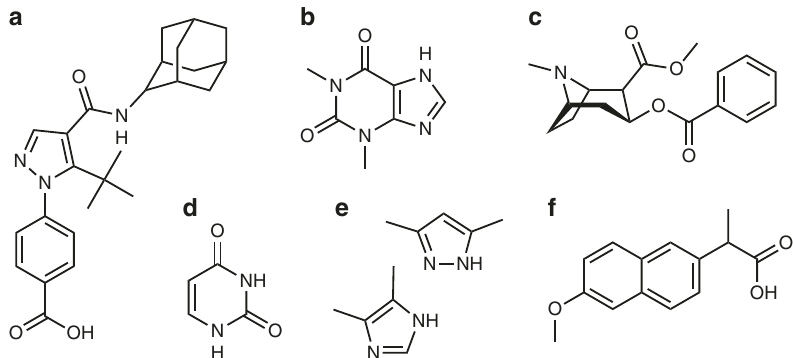
Fig. 6 Chemical structures of the six molecules used to evaluate the correlation between experimentally measured 1 H chemical shifts and the shifts calculated by ShiftML. The structures are given as AZD8329 ( a ), theophylline ( b ), cocaine ( c ), uracil ( d ), 3,5-dimethylimidazole and 4,5-dimethylimidazole ( e ) and naproxen (